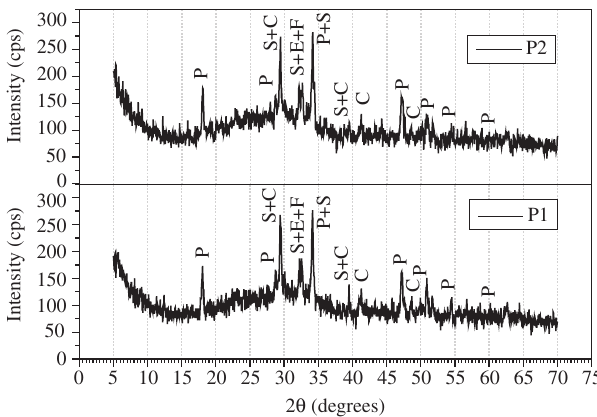
Figure 8. XRD patterns of the P1 and P2 pastes after 28 days of hydration. P. portlandite (Ca(OH) ); CC. Calcium carbonate (CaCO 2 (Ca [Al(OH) ] (SO ) .26H O); S. silicates; F. ferrite. 6 6 2 4 3 2